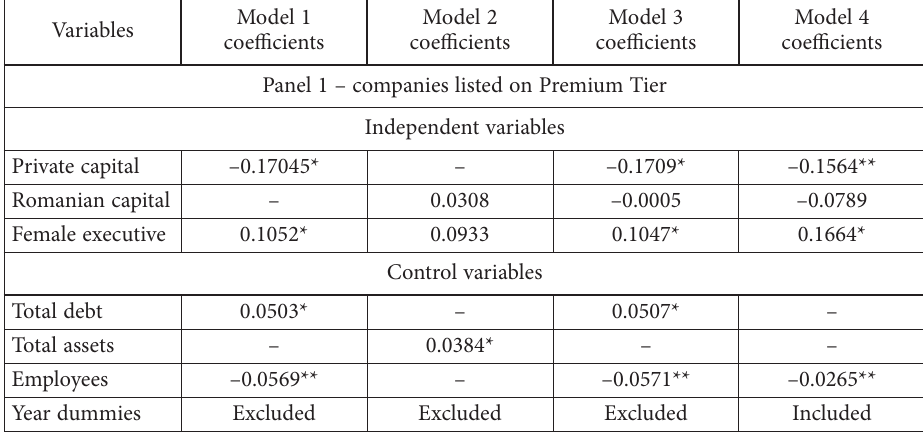
Table 2. Econometric modelling results with random effects (source: authors’ own calculation using Eviews software)